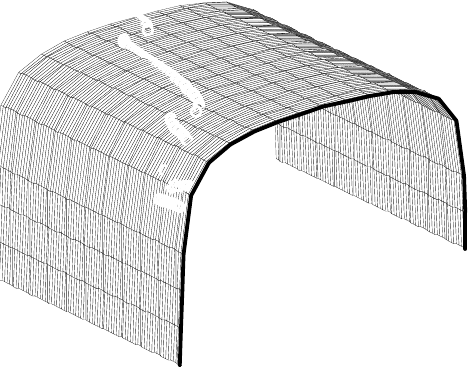
Figure 9. The position of the contact points on the surface of the wheel (rail inclination = 0). Similar as in the previous case, we are dealing here with quite clearly distinguished contact point zones. However, the differences in its positions are considerable, especially in the case of those zones corresponding to the situations when wheelset displacement is in the range from − 8 to ~4.2 mm. The positions corresponding to the contact with the flange are similar in both cases. We can observe a much bigger qualitative change for a rail inclination of 1:20, which is shown in Figures 10 and 11. Figure 10. The positions of contact points on the surface of a rail (rail inclination 1:20).